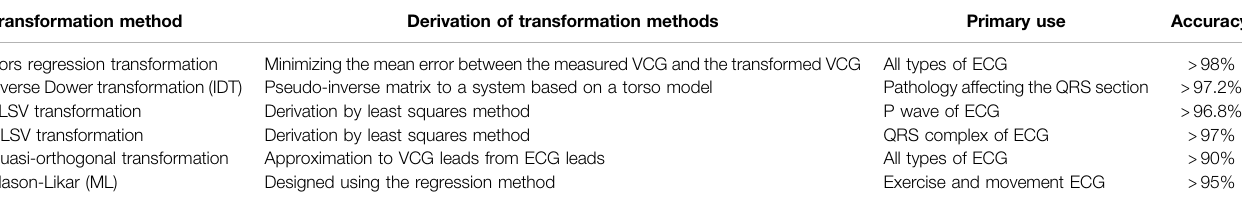
TABLE 8 | Overview of transformation methods.